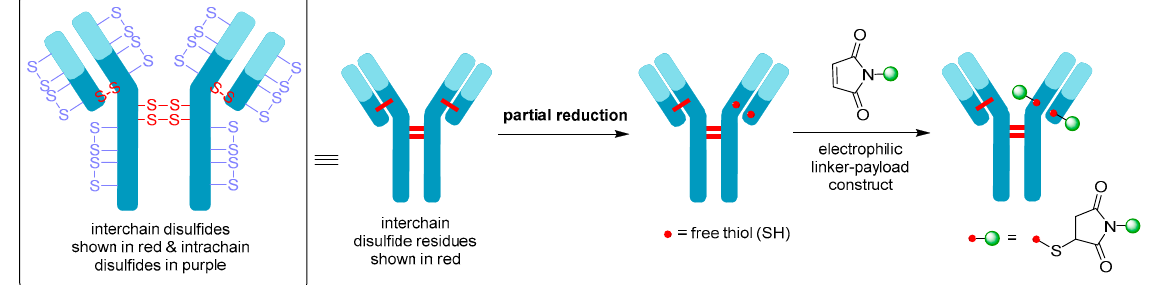
Figure 7. Schematic showing partial reduction of IgG1 antibody interchain disulfide bonds to generate two nucleophilic free thiol groups that can be reacted with an electrophilic linker-payload construct, such as maleimide (DAR = 2). Maleimide conjugation to cysteine is shown in this example.